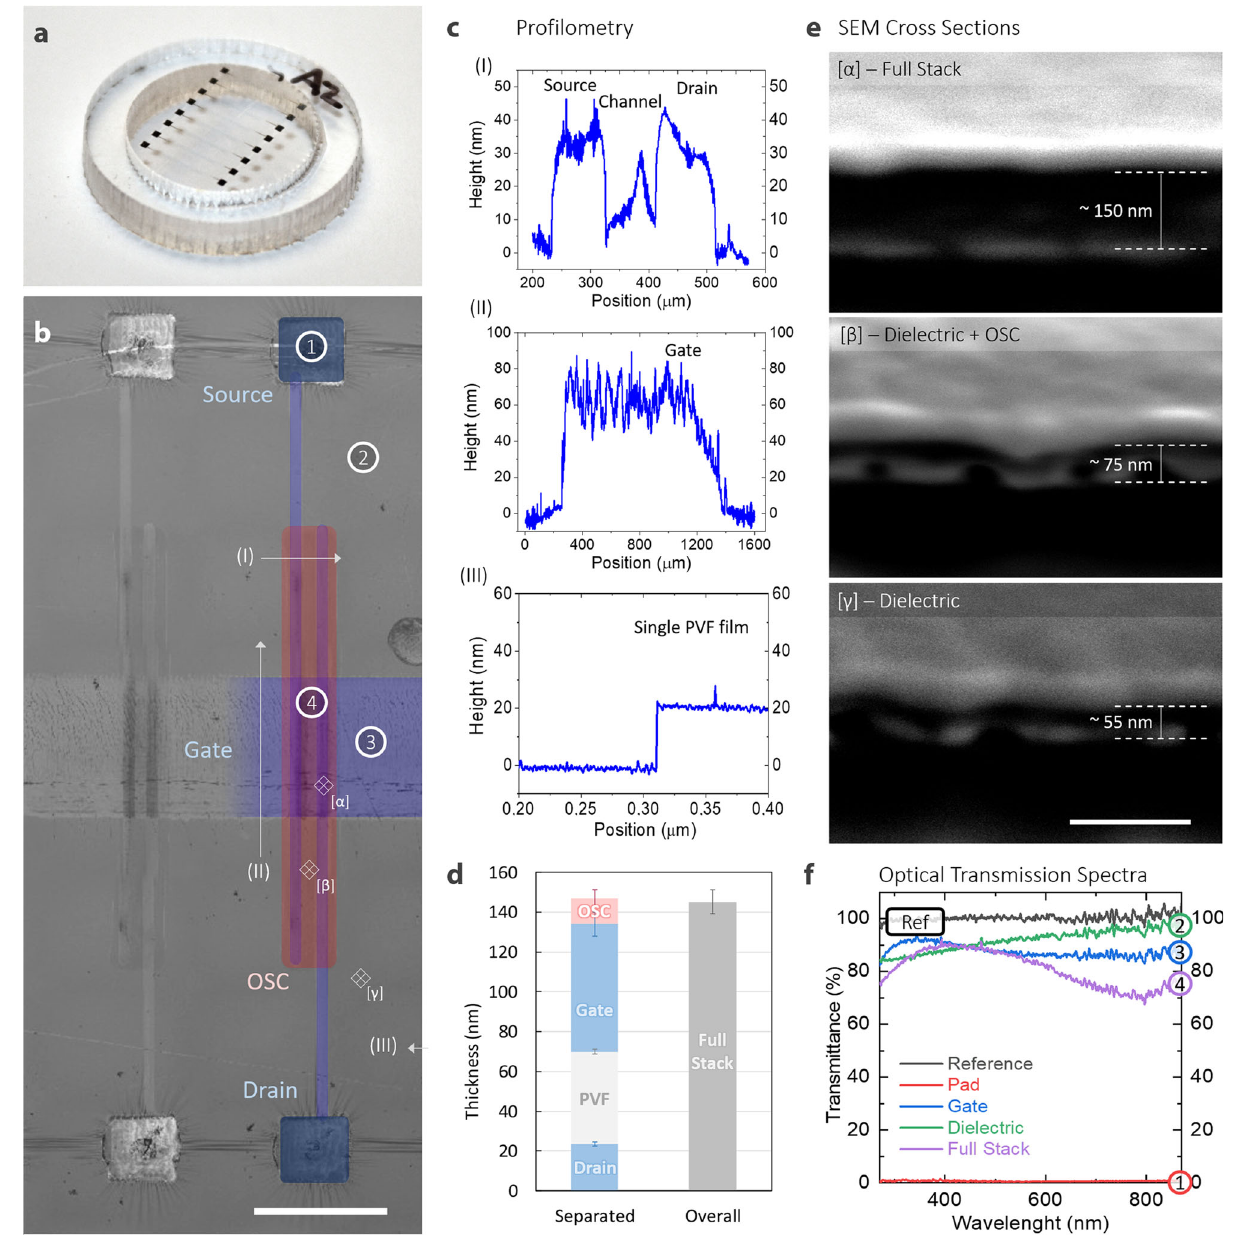
Fig. 2 Thicknesses and optical transmission spectra. a Photograph of the fi nal freestanding ultrathin OFET arrays suspended on a plastic ring. b Optical microscope image of two freestanding devices (right one colorized for clarity, scale bar 1 mm). Pro fi lometry locations, scanning electron microscopy cross sections and optical spectral measurements ( c , e , f ) are highlighted by numbered arrows, diamonds and circles, respectively. c Pro fi le measurements of the device in different locations: (I) source-drain channel and organic semiconductor; (II) gate electrode; (III) single PVF dielectric fi lm. d Results of thickness measurement (mean and standard deviation) by pro fi lometry of the different layers and of the overall device in a statistically signi fi cant number of samples (10 measurements for the full stack, 10 measurements for the PVF layer, 8 for the source/drain electrodes, 8 for the OSC, 6 for the gate electrode). e Scanning electron microscopy images of the cross section of the device in different positions obtained by focus ion beam etching (sample tilt 52°, scale bar 200 nm): section of the full stack ( α ), section of dielectric and organic semiconductor ( β ) and section of only dielectric ( γ ). f Optical transmission spectra measured in different positions (measurement spot diameter ~300 µ m): (1, red line) Ag covered pad transmittance, (2, green line) dielectric layer transmittance, (3, blue line) dielectric layer over bottom gate transmittance, (4, purple line) full stack transmittance; black line is lamp reference bottom gate is less than 70 nm and that of the top source/drain the thinnest ever produced. Scanning electron microscopy (SEM) electrodes covered by the semiconductor is ~40 nm, as shown in images of the device cross section obtained by means of focused Fig. 2c. In Fig. 2d, we compare the total thickness statistics ion beam (FIB) milling further support the thickness analysis obtained both by measuring the full stack and by summing the (Fig. 2e). The extreme thinness of PEDOT:PSS electrodes and of thickness obtained for each single layer in the stack. The two the semiconductor results in a high transparency of the device, values are in very good agreement, returning a total device with an overall average transmittance of more than 80% in the thickness of 143 ± 7 nm, thus qualifying the proposed OFET as visible range for the full stack (see Fig. 2f for the transmittance